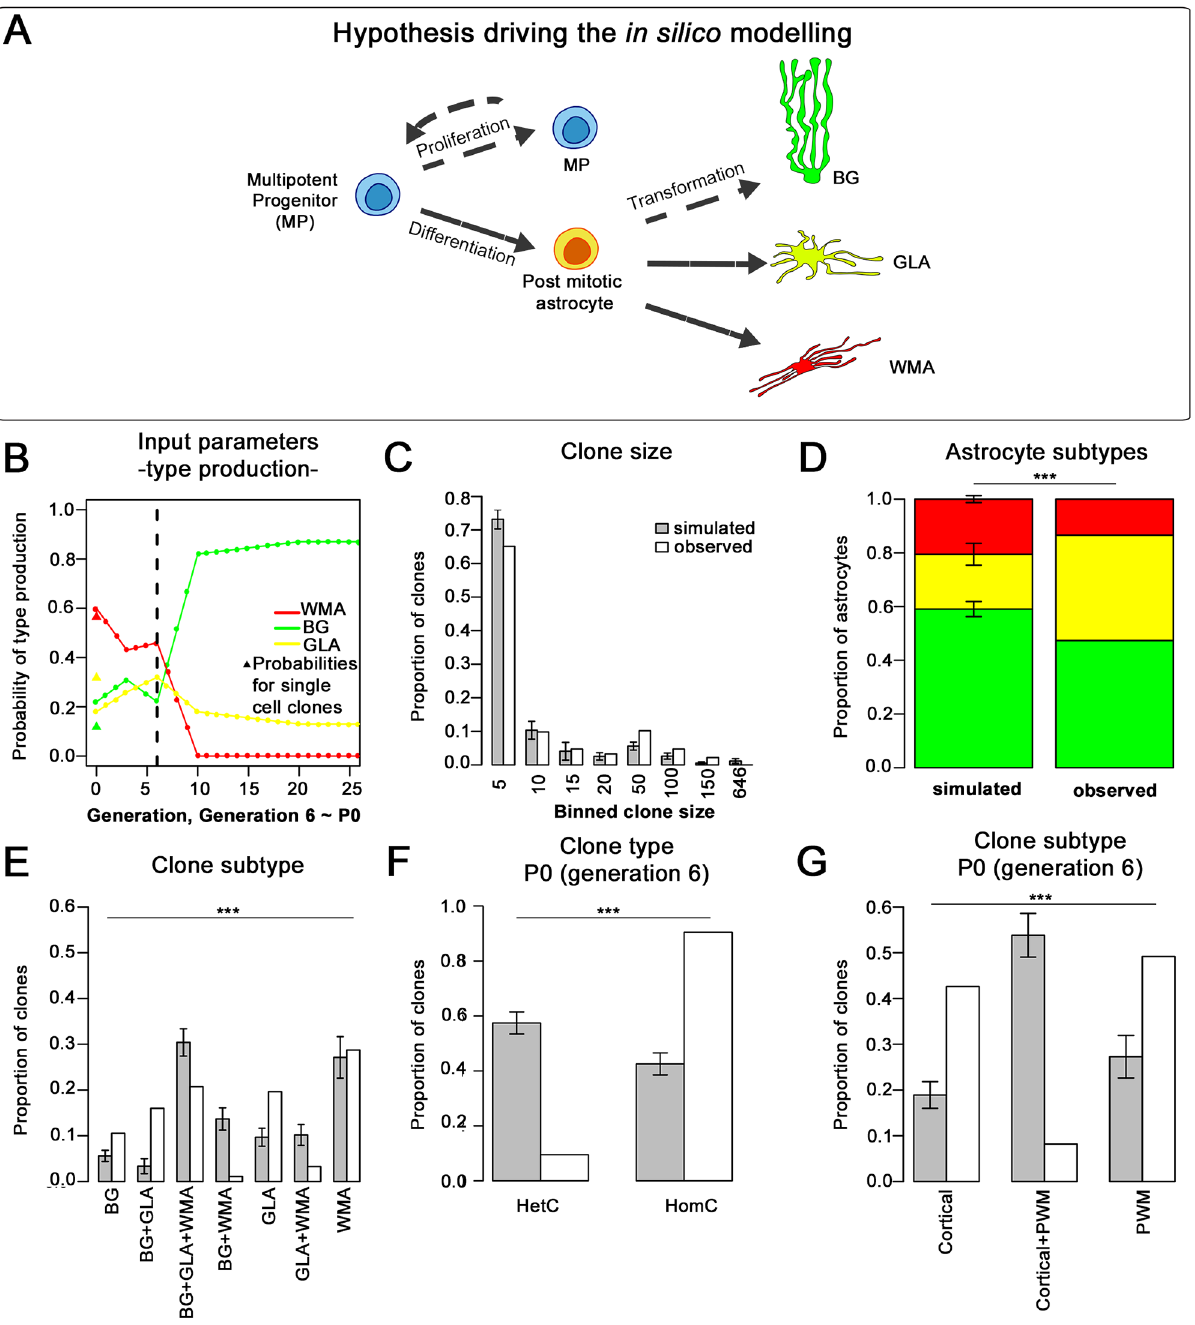
Fig 9. Rules and outcome of the simulation model applied to E12 lineages. (A,B) The schematic representation in (A) shows the distinct fate transitions allowed in the model (indicated by the arrows). The probability of MP proliferation is kept constant at 0.465 in the simulations of E12-P30 lineages. Each daughter cell of each division either remains an MP or differentiates into a postmitotic astrocyte. In this latter case, the probabilities of generating the distinct astrocyte subtypes (BG versus GLA versus WMA) are generation-dependently set according to the birthdating experiments performed in the hemispheres, as shown in (B). Histograms in (C-E) show the outcomes of the simulated lineages compared to the experimental data. Simulated clone sizes (C) appear quite similar to those of the observed clones. On the other hand, the proportions of astrocyte subtypes are not well represented, with too many WMAs and BG produced (D). Same color code as in (A). Similarly, the model fails to recapitulate the proportions of clone subtypes (E; E12-P30). (F,G) Simulated and observed lineages were compared at P0 (corresponding to generation 6). Too many HetCs (F) are found in simulated lineages compared to empirical clones, because of the generation of too many PWM+cortical clones at the expense of both cortical and PWM families (G). (cid:3)(cid:3)(cid:3) , P < 0.001; P values are calculated with chi-squared test. Cortical clones comprise PCLp HomCs, GLAp HomCs, and PCLp+GLAp